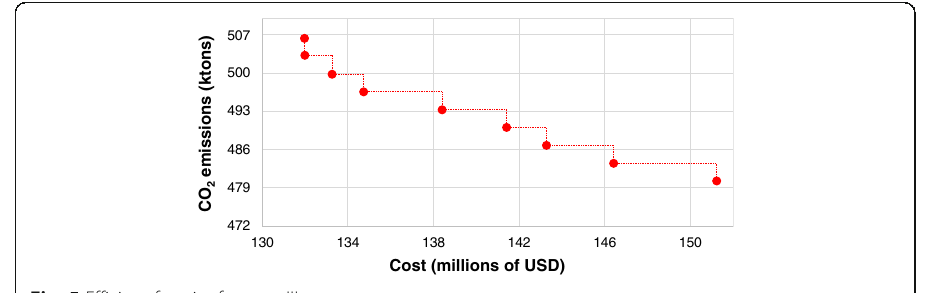
Fig. 5 Efficient frontier for case